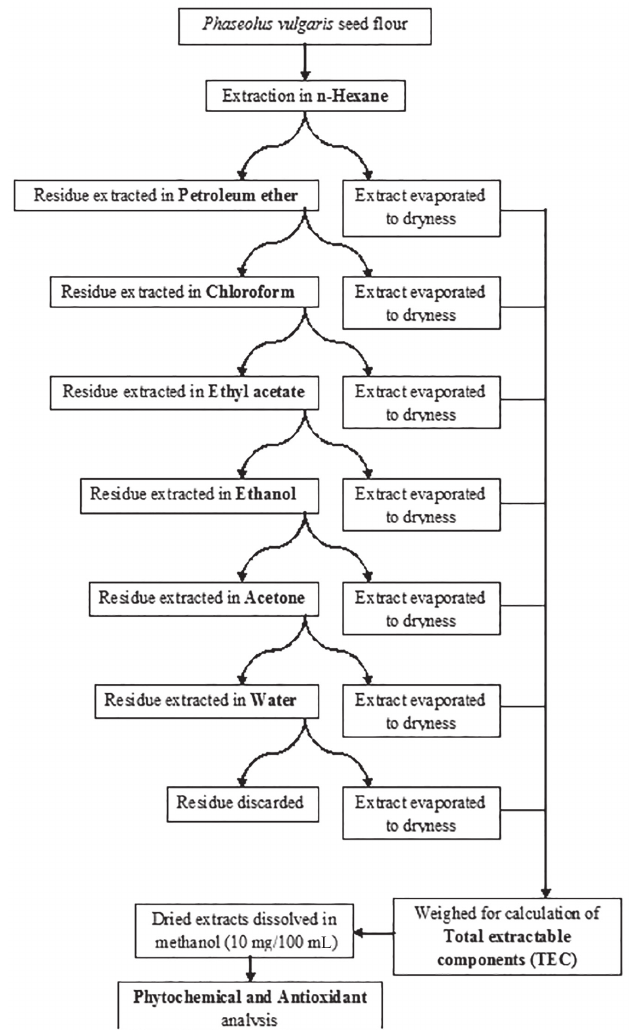
FIGURE 1 - Experimental scheme for extraction of